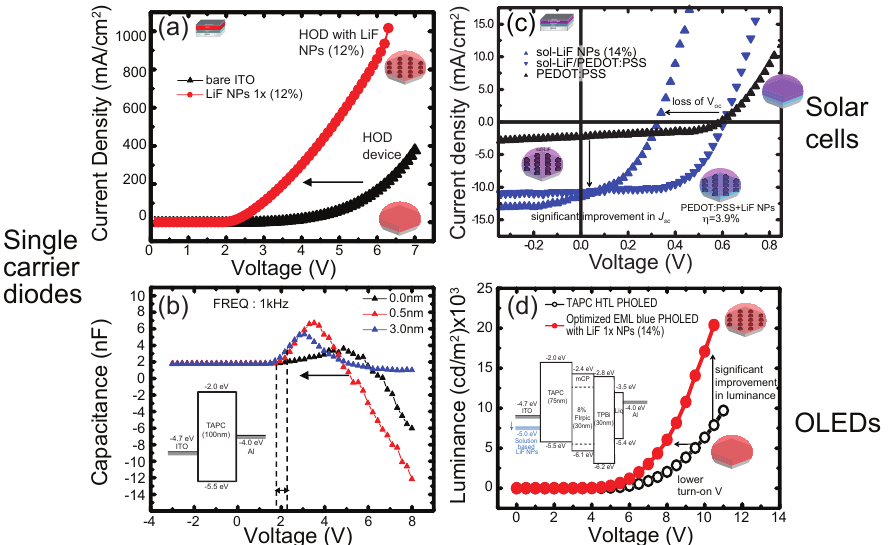
Figure 8. ( a ) Current density–voltage of single layer hole-only devices (HODs) using a TAPC hole transporting layer sandwiched between Al and ITO, with and without solution deposited LiF nanopar- ticles on the ITO surface. Insets show schematically the device structure and ordered uniform array of nanoparticles. Adapted with permission from Springer Nature from Ref. [61] Copyright (2021). ( b ) Capacitance–voltage characteristics of single layer hole–only devices (HOD) with submonolayer (0.5 nm) and evaporated LiF and on the ITO electrode. Inset shows the expected energy levels for the device structure. Adapted with permission from Springer Nature from Ref. [61] Copyright (2021). ( c ) Typical illuminated current density–voltage (J–V) curves for polymer-fullerene photovoltaic cells with various anodes. Insets show schematically the device structure and ordered uniform array of nanoparticles. Adapted from Ref. [74] with the permission of AIP Publishing. ( d ) Luminance–voltage characteristics of blue phosphorescent OLED using a TAPC hole transport layer. Inset shows the ex- pected energy levels for the device structure, as well as the ordered uniform array of nanoparticles. Adapted with permission from Springer Nature from Ref. [61] Copyright